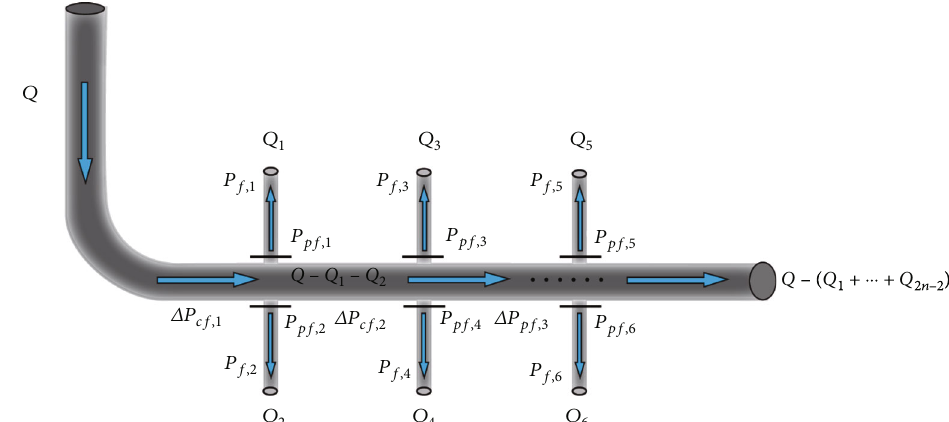
Figure 2: Illustration of fracturing fl uid distribution and pressure drop.